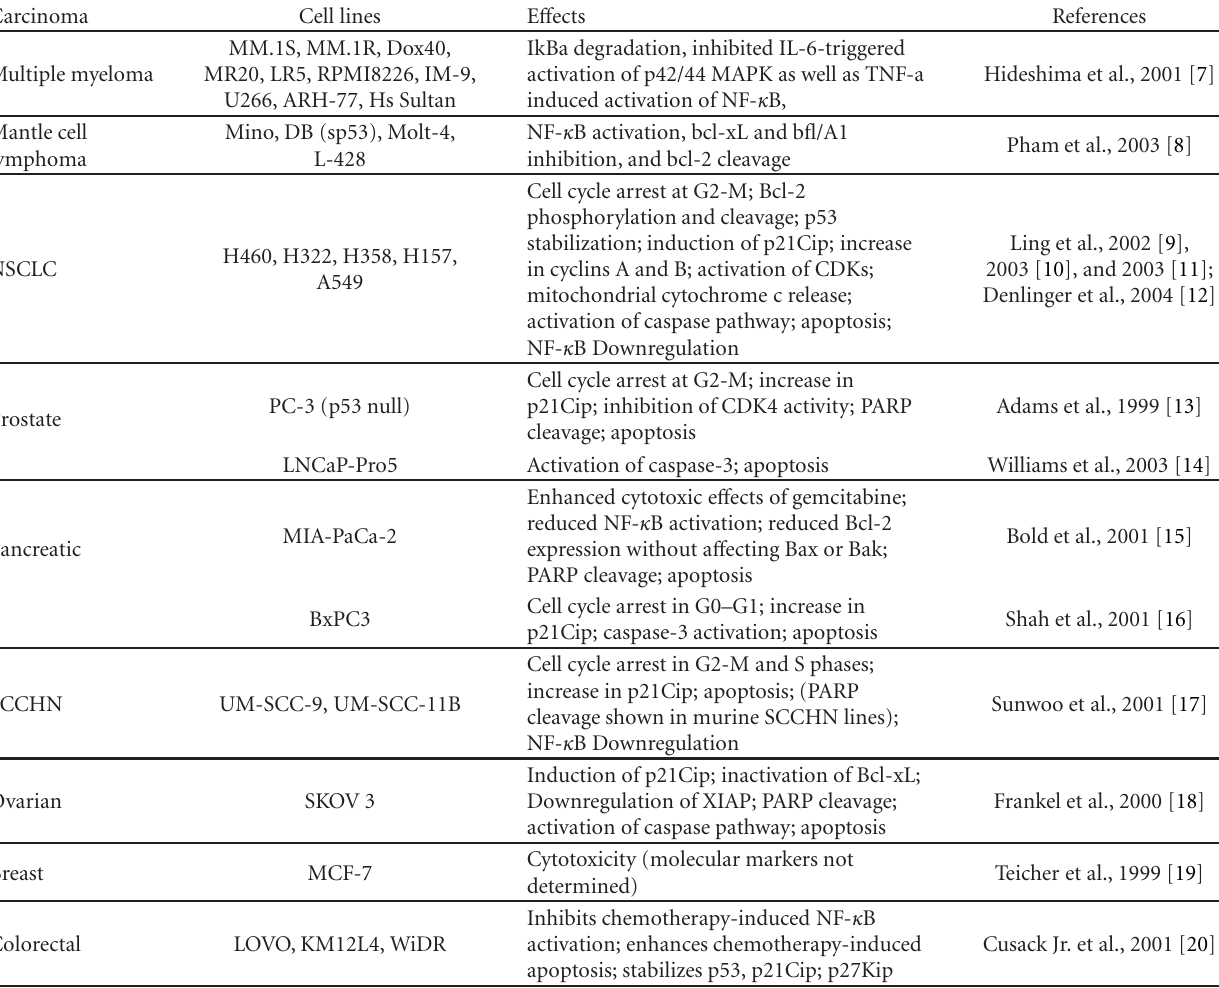
Table 2: In vitro studies with